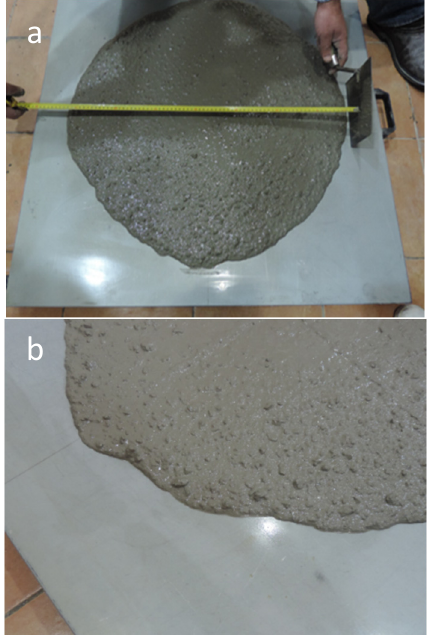
Figure 7. Slump flow test: a) Slump flow test for mix SCC, b) Edge of SCC mix during the slump flow test.